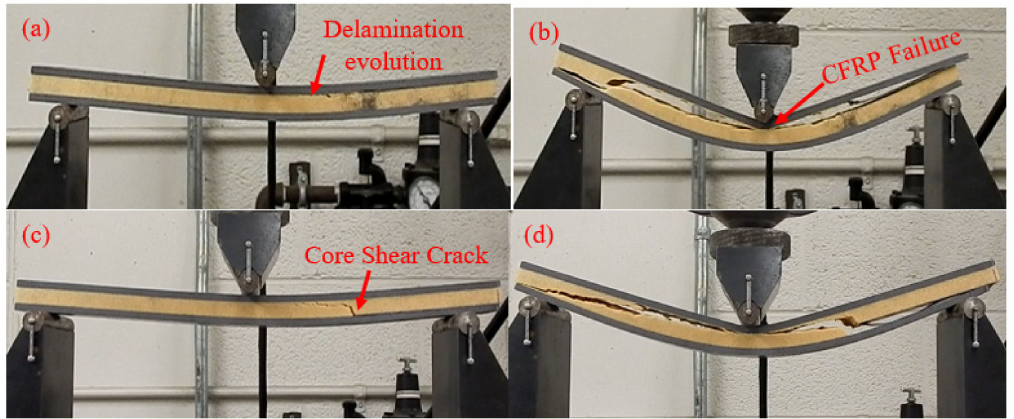
Figure 9. Damage morphologies of a CFRP / PU sandwich beam that had a thin core tested under three-point loading; ( a , b ) initial interfacial crack on the compression side; ( c , d ) initial interfacial crack on the tensile